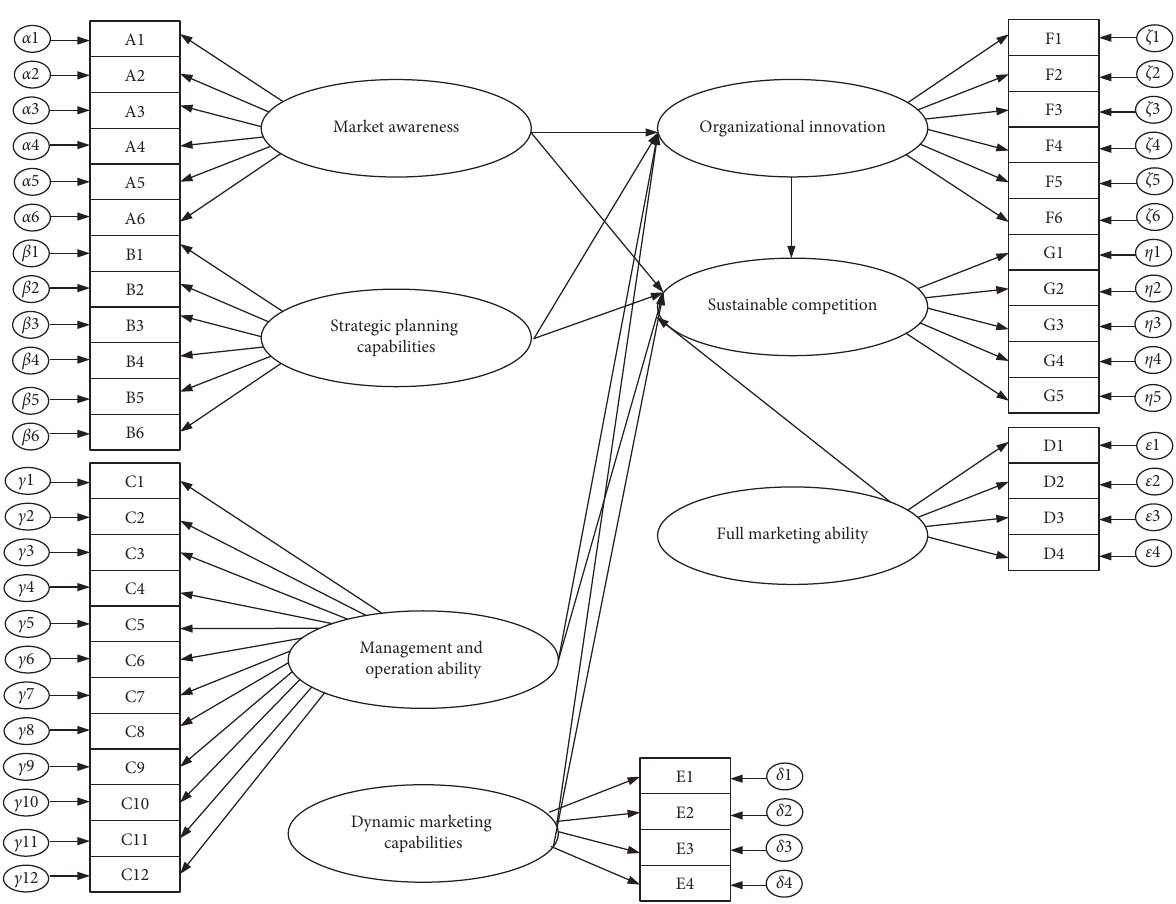
Figure 3: Model test to identify core marketing capabilities of high-tech enterprises. Table 3: Theoretical model fit